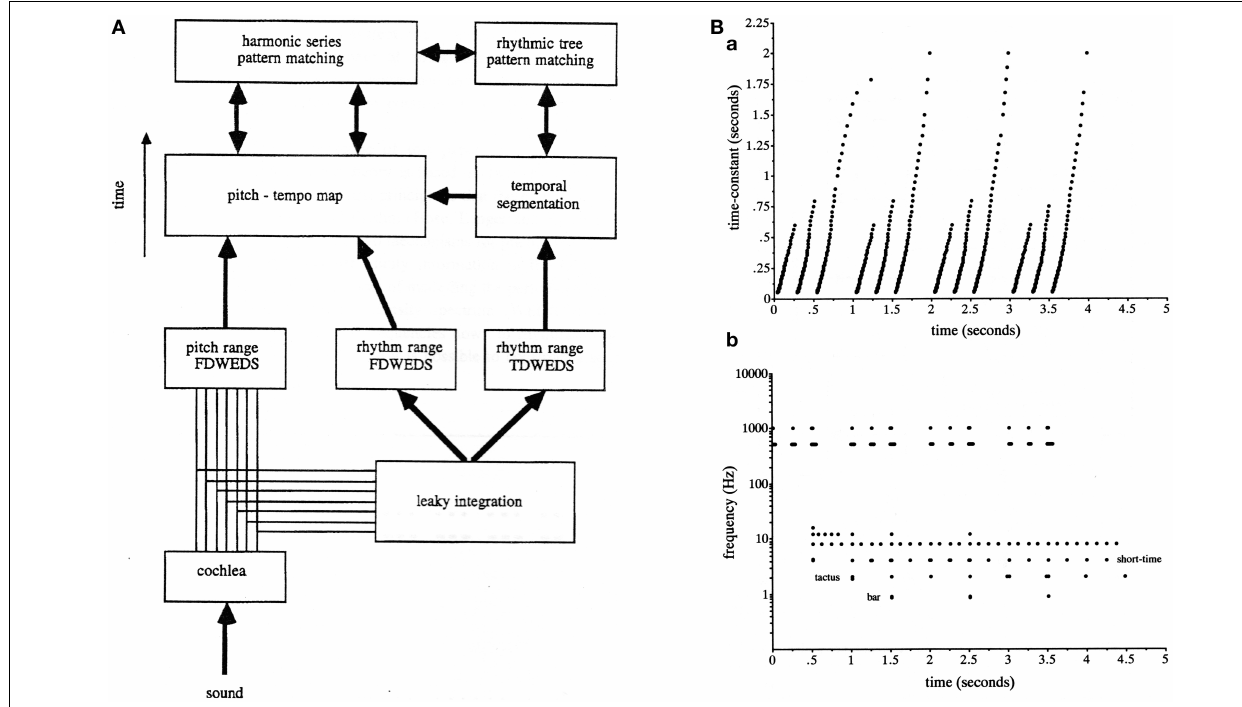
FIGURE 2 | (A) A reproduction of Figure 16 from Todd (1994a) illustrating the scheme for computing a modulation spectrum in both pitch and rhythm frequency ranges and in parallel both low-pass and band-pass representations. The abbreviation FDWEDS stands for “frequency domain windowed energy density spectrum” (i.e., the output of a band-pass filter